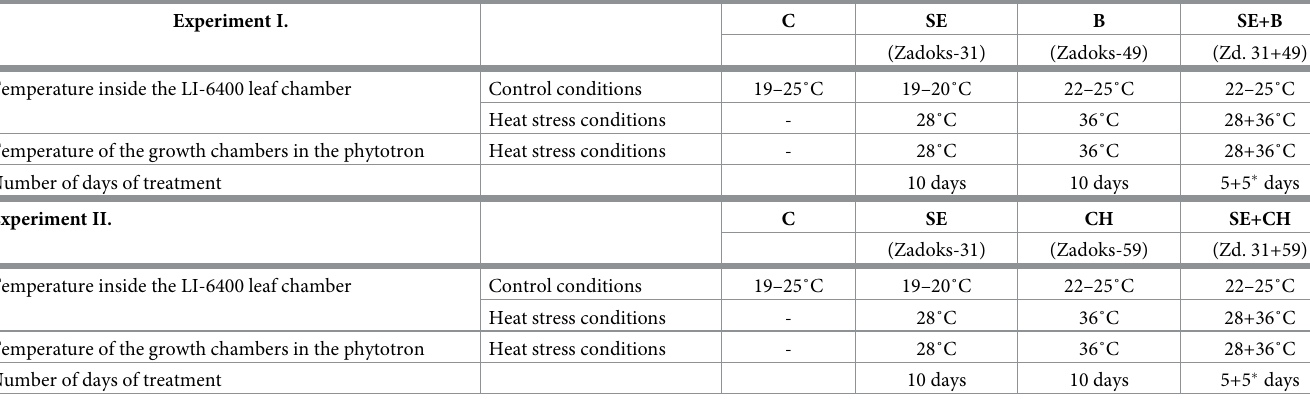
Table 1. Temperature values for the photosynthetic measurements in LI-6400 and temperature values of the stress chambers. Experiment